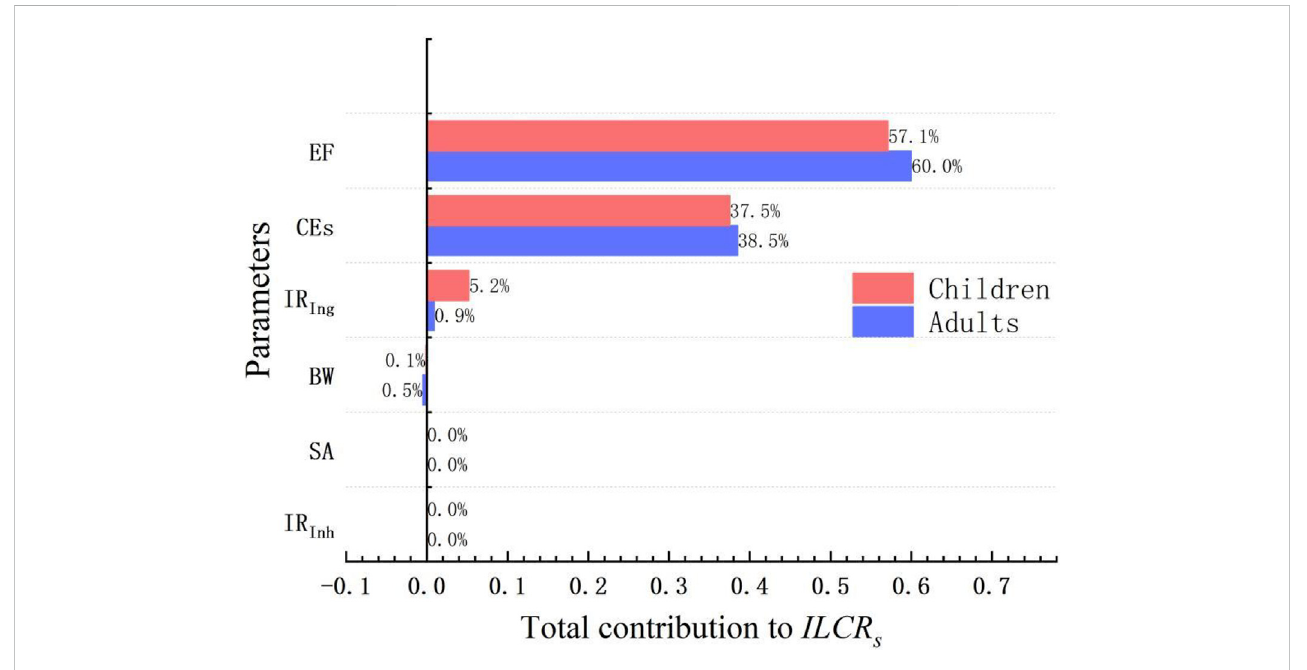
FIGURE 5 Contribution of parameters for probabilistic ILCRs